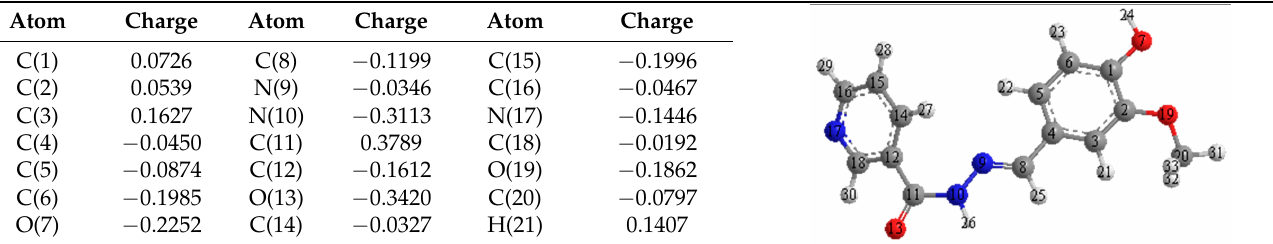
Table 4. Mulliken atomic charges for the corrosion inhibitor.